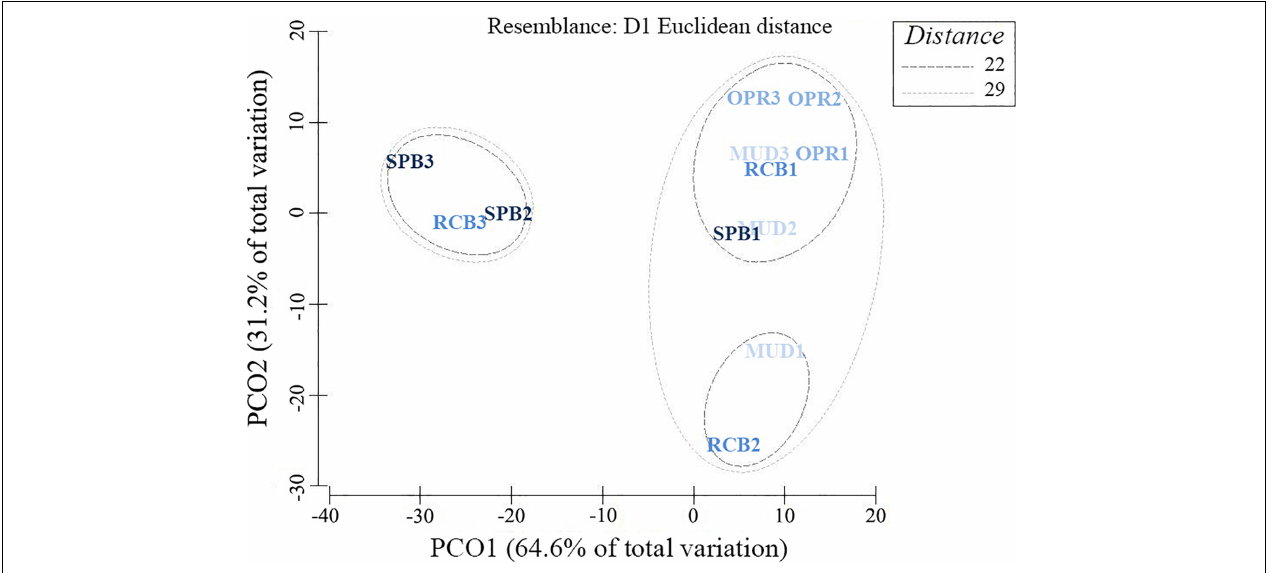
FIGURE 3 | Principal Coordinates Analysis using seven grain-size ranges and their proportion in 100 g dry weight of sediments. Sampling sites differentiated by colors (and exposure levels) as MUD (I), OPR (II), RCB (III) and; SPB (III). And sampling stations (depth factor) differentiated by numbers (site 1 as deep, site 2 as mid and site 3 as shallow water station). Resemblance values based on means from six replicates per sampling station (data from both seasons were